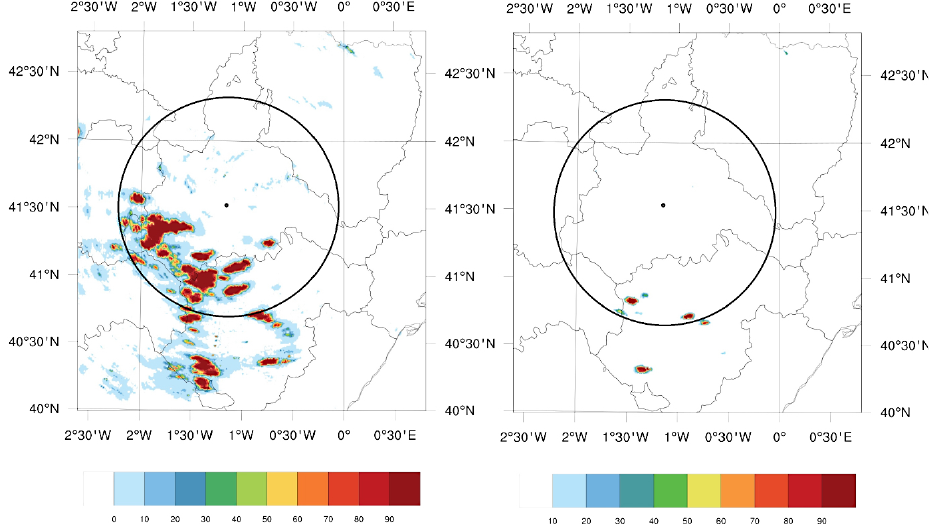
Fig. 5. 12 August 2011. Left: radar-based accumulated hail likelihood for entire day in MEV. Right: radar-based hail likelihood at 14:00UTC. Convective cells with high hail likelihood are marked in red. Circled area shows the 100km radar range